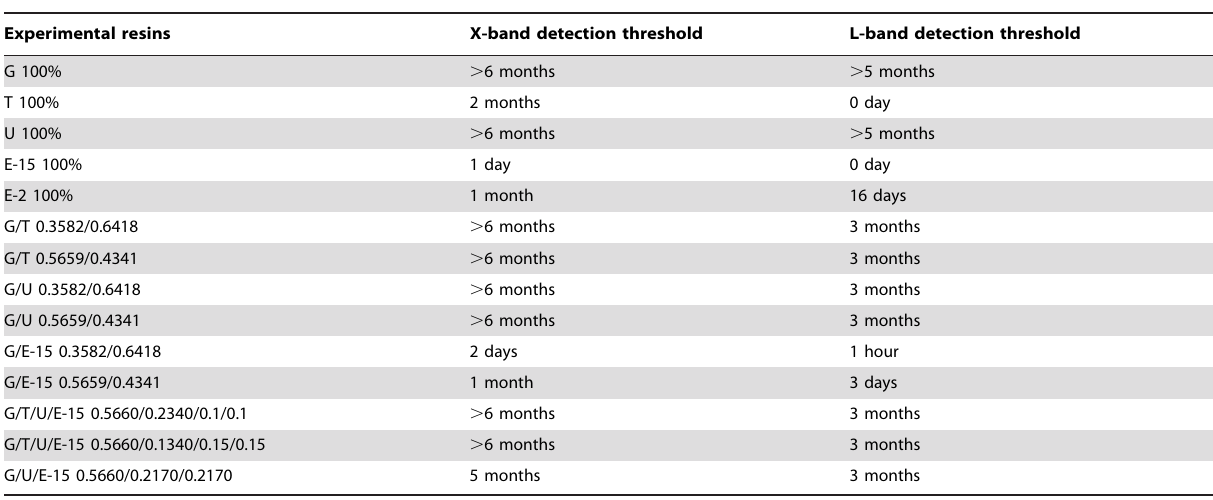
Table 8. Detection limit of the EPR signal for experimental resins and mixtures, expressed as the time period needed for disappearance of the signal under the measurements